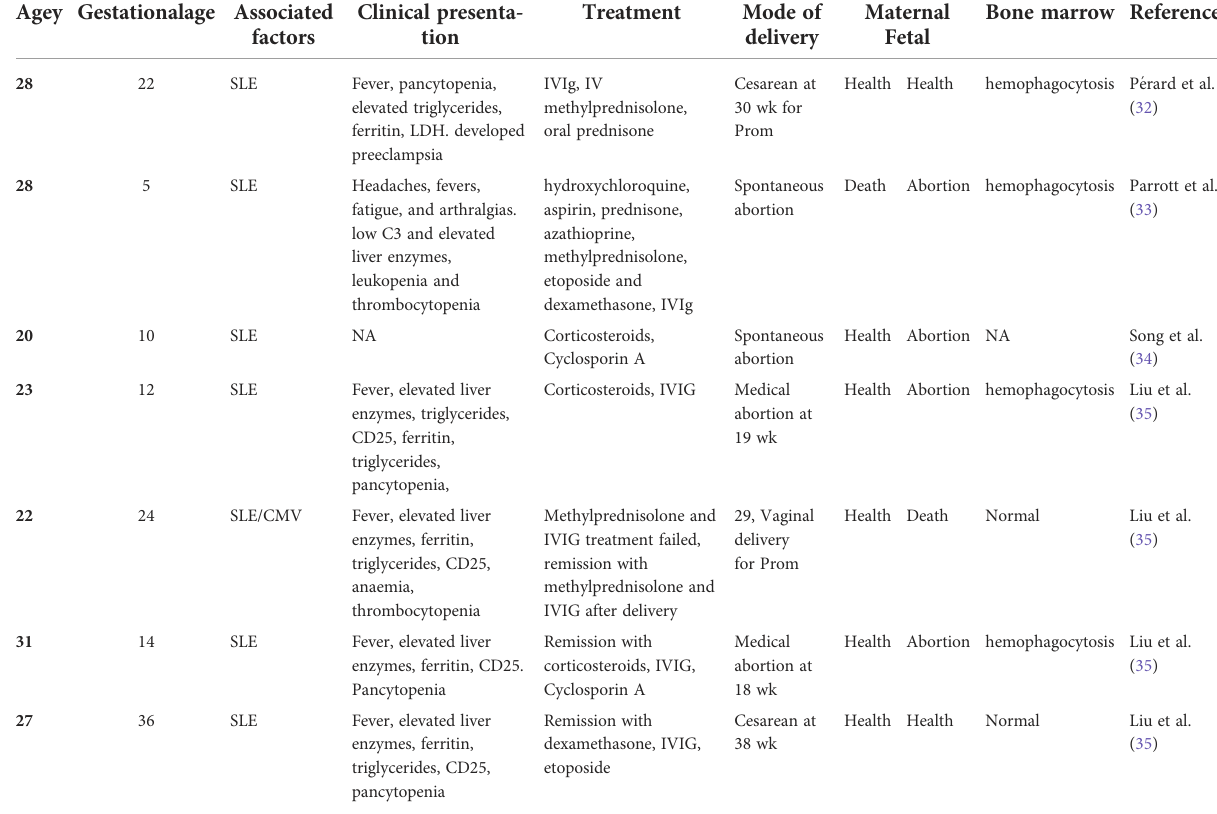
TABLE 2 Characteristics of patients with SLE in the literature with HLH during pregnancy. Agey Gestationalage Associated